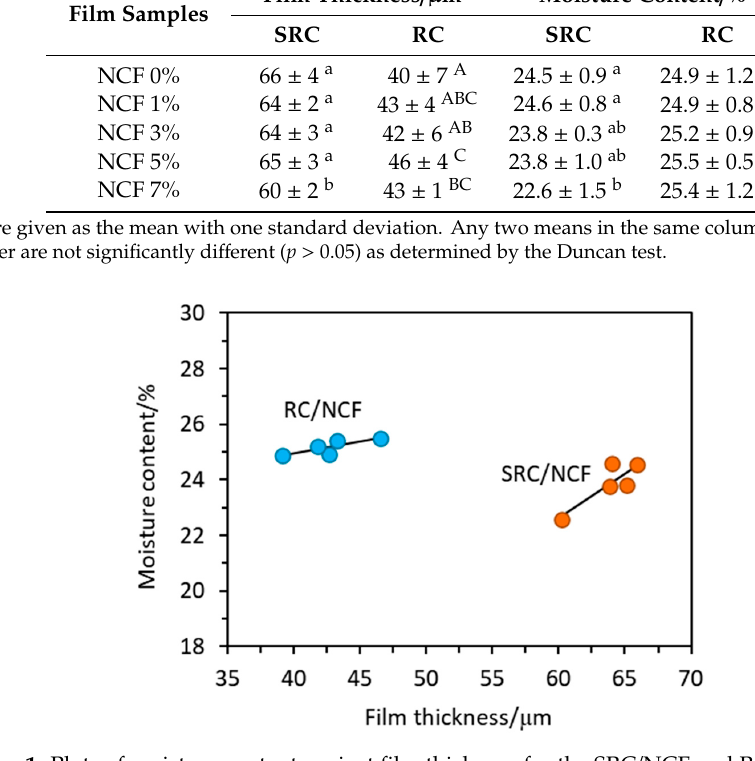
Table 1. Film thickness and moisture content of the semi-refined carrageenan (SRC)/nanocellulose fibrils (NCF) and refined carrageenan (RC)/NCF films. Film Thickness / µ m Moisture Content / % SRC RC Film Samples